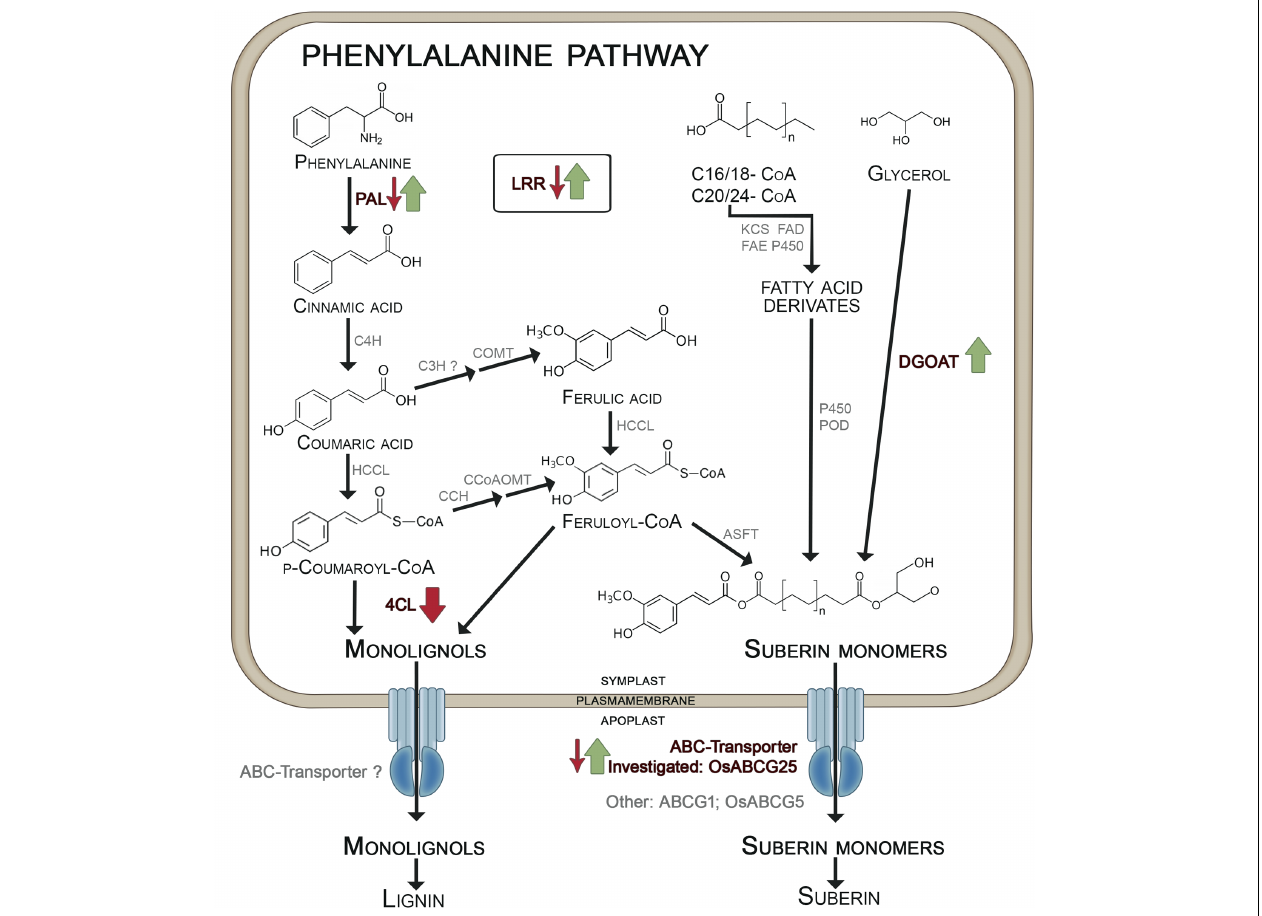
FIGURE 6 | Differential expression of genes involved in exodermal CB development in mutants of OsABCG25. KO mutant: small arrows; OE mutant: big arrows. Phenylalanine-ammonia-lyase (PAL) catalyzes the formation of cinnamic acid which is metabolized by cinnamate-4-hydroxylase (C4H) to coumaric acid. Ferulic acid is built by coumaroyl-CoA-3-hydroxylase (C3H) and caffeic acid O-methyltransferase (COMT). Hydroxycinnamate-CoA-ligase (HCCL) catalyzes the formation of coumaryl-CoA and feruloyl-CoA which are converted to monolignols by 4-coumarate ligase (4CL) (Zhong et al., 1998; Eckardt, 2002). From coumaryl-CoA also feruloyl-CoA is generated by p-coumaroyl CoA 3-Hydroxylase (CCH) and caffeoyl-CoA O-methyltransferase (CcoAOMT) which is bound to suberin monomers by aliphatic suberin feruloyl transferase (ASFT). The aliphatic components of suberin monomers originate from fatty acid derivates and glycerol, which is incorporated by diacylglycerol O-acyltransferase (DGOT) (Franke et al., 2005; Franke and Schreiber, 2007; Li-Beisson et al., 2013). Both, monolignols and suberin monomers are transported by ABC-transporter from the symplast into the apoplast. We suggested that the investigated OsABCG25 transports suberin monomers. Other suberin transporters are ABCG1 (Landgraf et al., 2014) and OsABCG5 (Shiono et al., 2014). Further proteins are: CCH, p-coumaroyl CoA 3-hydroxylase; FAD, fatty acid desaturase; FAE, fatty acid elongase; KCS, β -ketoacyl-Coa synthase; LRR, leucine-rich repeat family protein; P450, cytochrome P450 monooxygenase; POD, peroxidase. Arrows indicate significant regulation in KO/OE mutants vs. +WT/ − WT ( p -value > 0.01), green stands for upregulation, red stands for downregulation. The scheme based on Eckardt (2002) and Franke and Schreiber (2007).